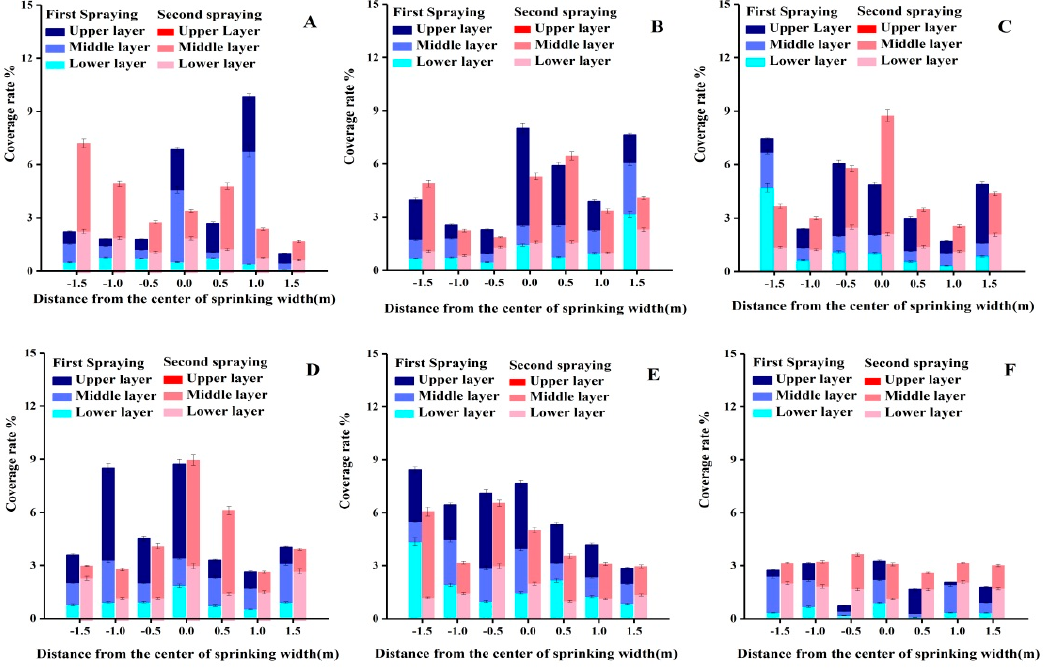
Figure 3. Effect of aviation spray adjuvants on coverage rate of droplets in cotton canopy sprayed by UAV. ( A ) 300 mL / ha Beidatong; ( B ) 150 mL / ha Nongjianfei; ( C ) 75 mL / ha Star Guar X; ( D ) 150 mL / ha Maifei; ( E ) 150 mL / ha Y-20079; and ( F ) control without aviation spray adjuvants.